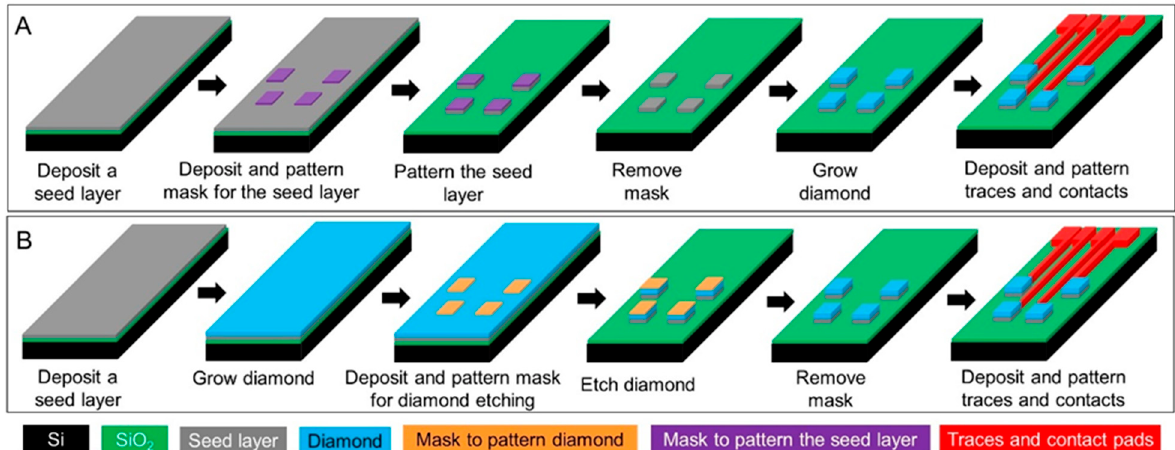
Figure 2. Schematic plots of the two typical microfabrication methods for making diamond microelectrode arrays. ( A ) The bottom-up approach where diamond electrodes are grown directly on a pre-patterned seed layer. ( B ) The top-down approach where a continuous diamond film is grown on the seed layer followed by diamond etching to form the electrode patterns.